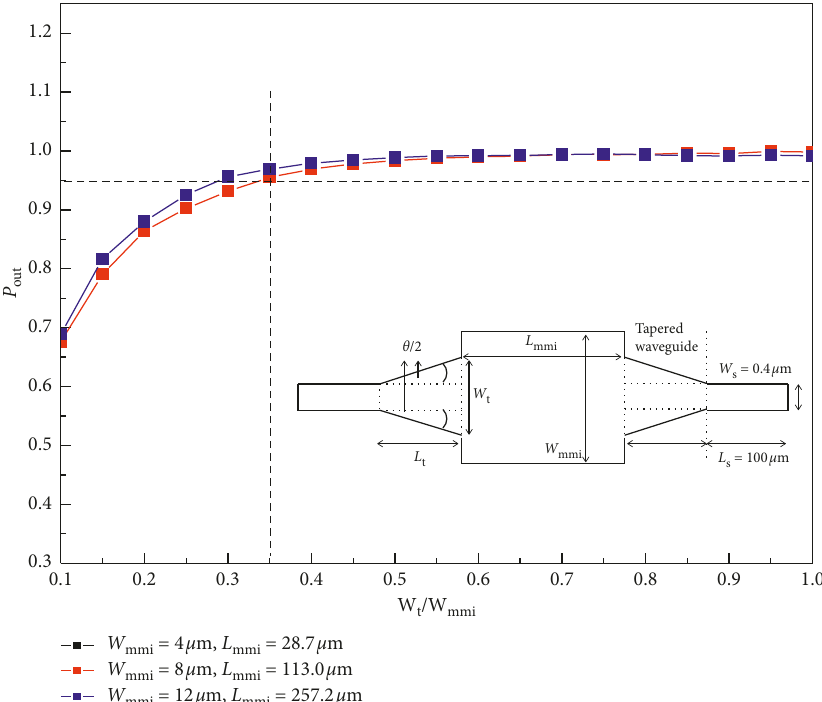
Figure 4: This linear tapered waveguide with a divergence angle of 1 ° is combined with the three different widths of a 1 × 1 MMI coupler W mmi of 4 μ m/8 μ m/12 μ m with respect to the exact imaging lengths L mmi of 28.7 μ m/113.0 μ m/257.2 μ m. When W t / W mmi is set at above 0.35, the output power P of a 1 × 1 MMI coupler combined with a linear tapered waveguide achieves above out